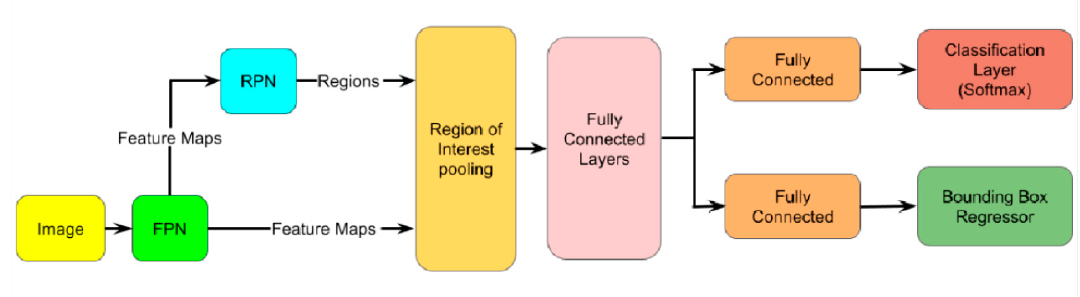
Figure 6. Faster R-CNN FPN architecture overview.